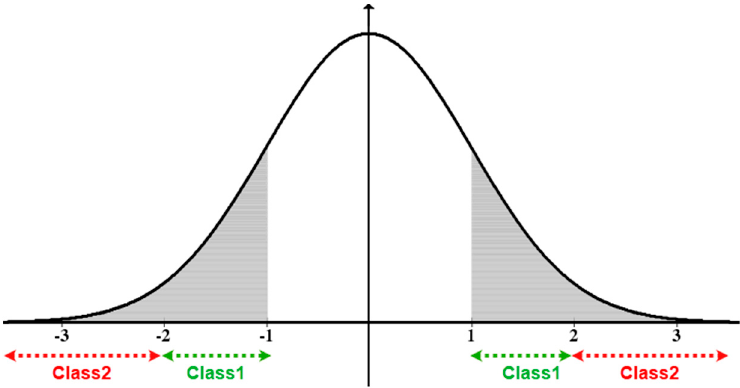
Figure 9. Proposed anomaly classification using the normal distribution.